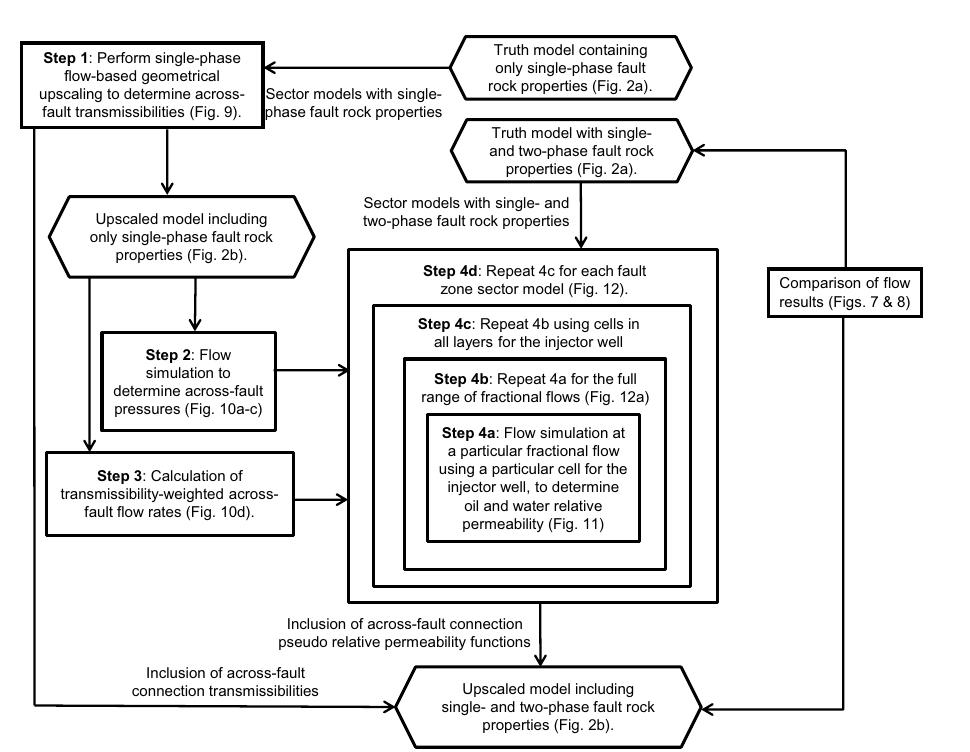
Figure 6. The workflow developed in this paper. Rectangles represent steps in the procedure, arrows record the transfer of information, and hexagons shows the four versions of the simulation